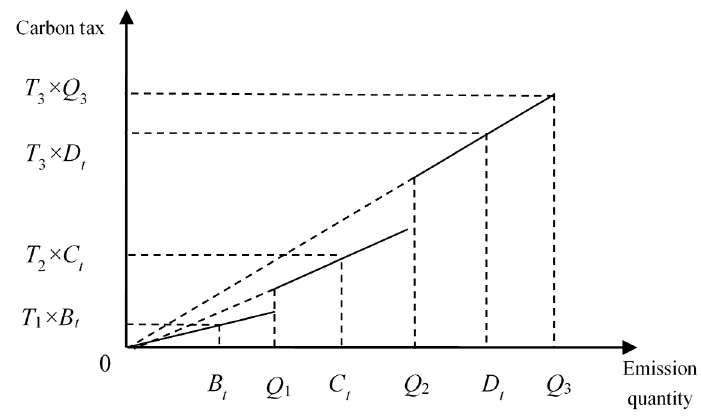
Figure 3. The fixed tax rate.